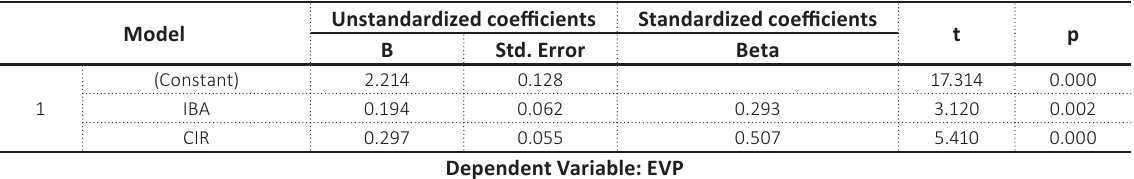
Table 8. Simultaneous influence of IBA and CIR on EVP